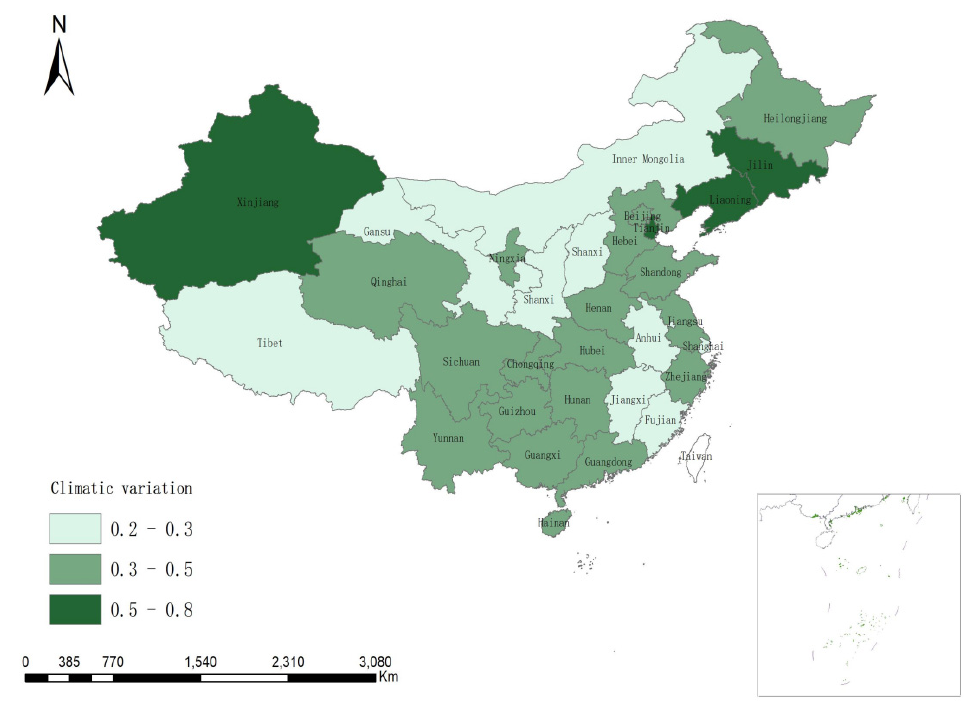
Figure 3. Standard deviation of the average temperature in provinces in 2019.